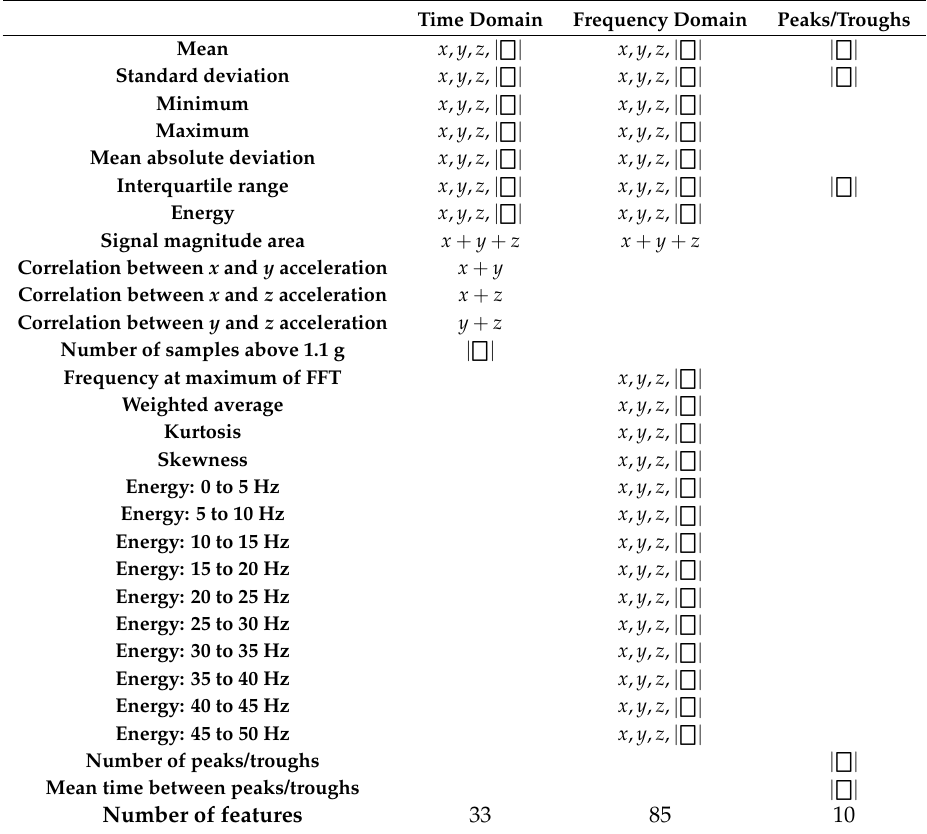
Table A1. Considered features in this